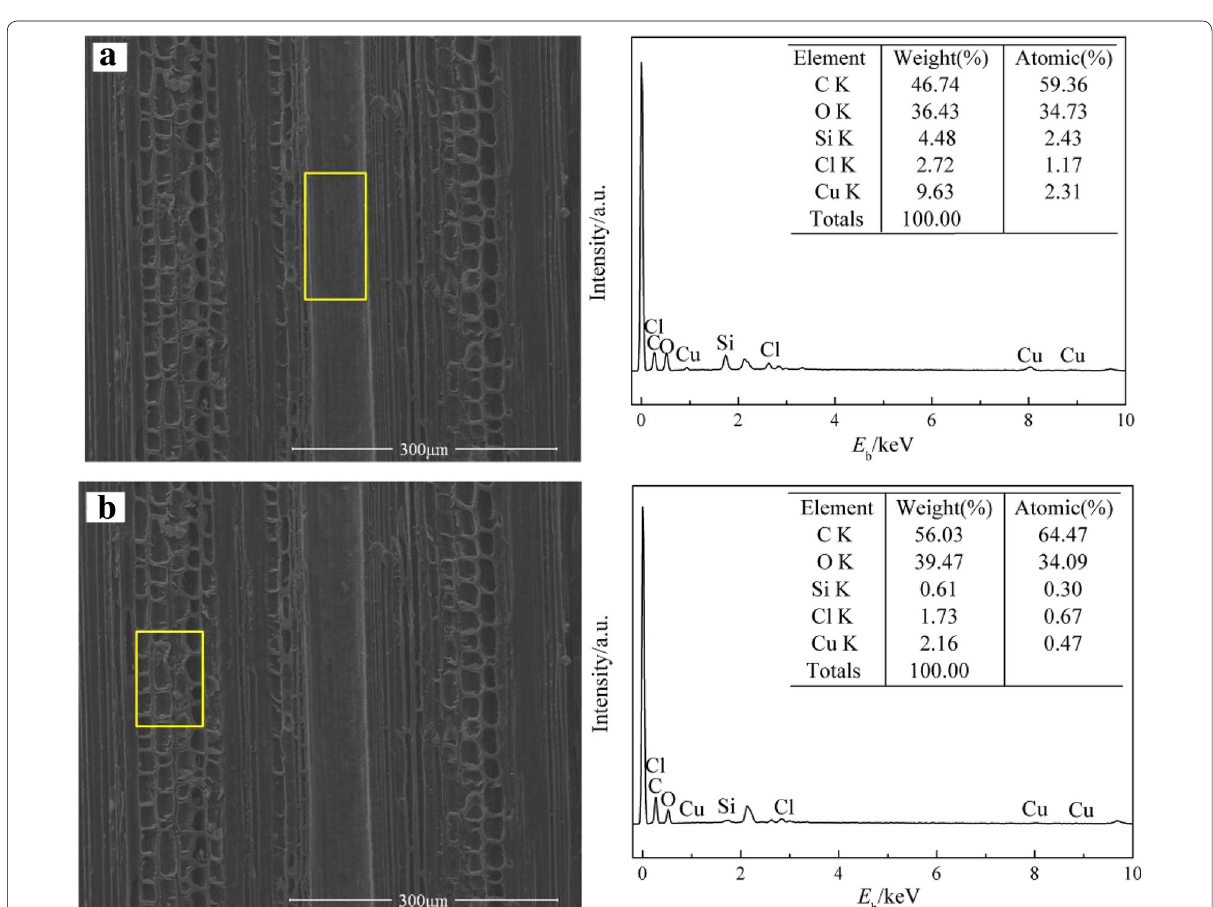
Fig. 6 SEM–EDS spectra of the central region of the longitudinal section of HSM-treated bamboo. a Vessel. b